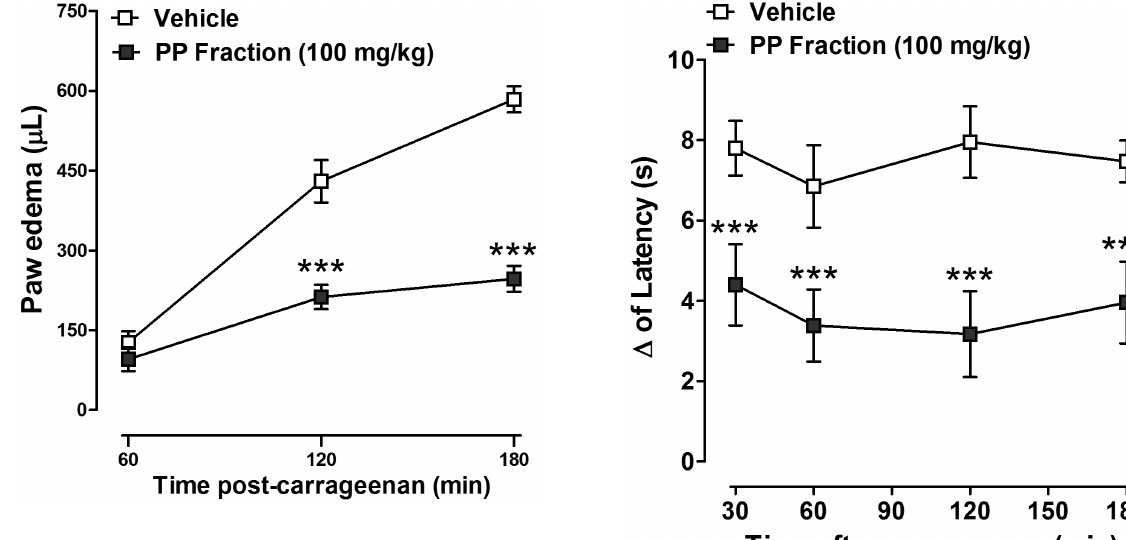
Figure 4 - Effect of PPAC fraction (100 mg/kg; po) on carrageenan-induced rat hyperalgesia. Each point represents the mean ± SEM of 7–10 animals. ***p<0.001 in a two-way ANOVA Bonferroni post-test.